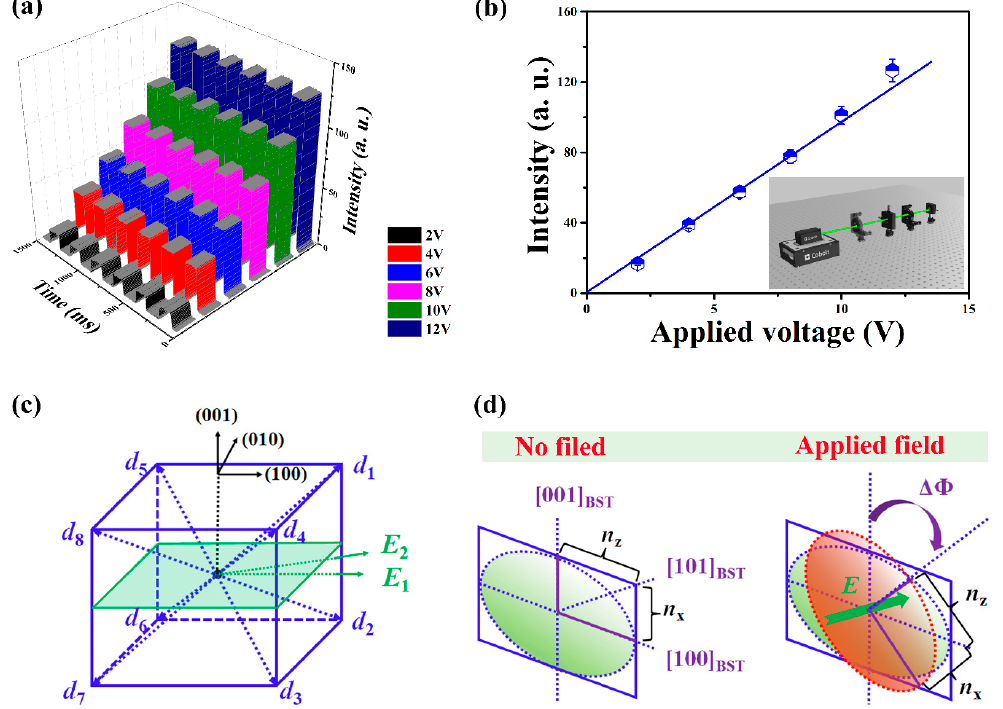
Figure 6. ( a ) Light manipulation as functions of the applied voltage. ( b ) The relationship between the laser intensity and the applied voltage. The inset is the schematics of experimental setup. ( c ) Eight possible spontaneous polarization directions in BST along (001). ( d ) reveals the projected ellipses on (001) plane of BST with and without the applied electric field. Applying an electric field E change the birefringence ( △ n ) and rotates the optical axis as well.